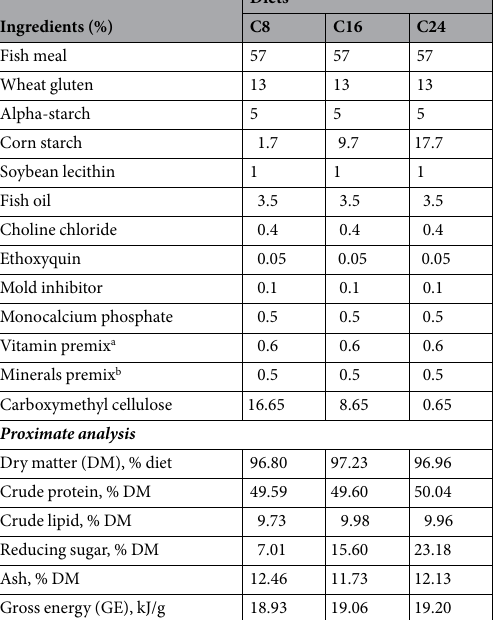
Table 5. Formulation and proximate chemical composition of diets. a Vitamin premix (g kg − 1 of mixture): microcrystalline cellulose, 16.473; VA, 0.032; VB 1 , 0.025; VB 2 , 0.045; VB 6 , 0.02; VB 12 , 0.01; VD, 0.035; VE, 0.24; VK, 0.01; calcium pantothenate, 0.06; nicotinic acid, 0.2; folic acid, 0.02; biotin, 0.06; inositol, 0.8; VC phosphate, 2. b Mineral premix (g kg − 1 of mixture): MgSO 4 · 7H 2 O, 1.2; CuSO 4 · 5H 2 O, 0.01; FeSO 4 · H 2 O, 0.08;